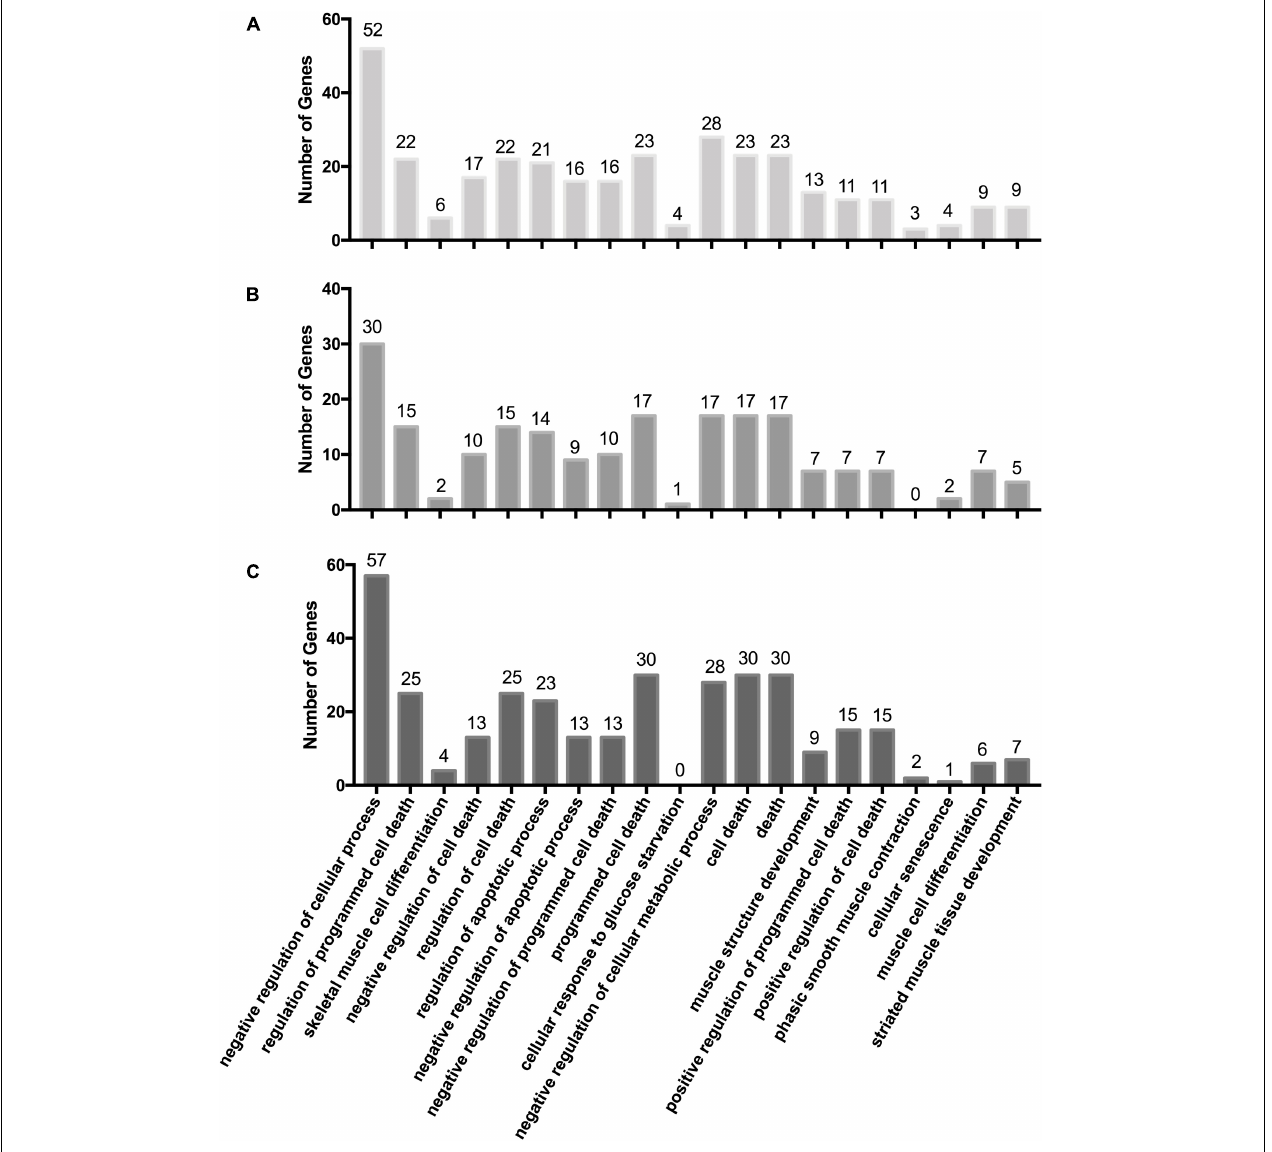
FIGURE 2 | GO terms associated with cellular processes and muscle development. (A) W14 vs. W6 group. (B) W22 vs. W14 group. (C) W30 vs. W22 group.